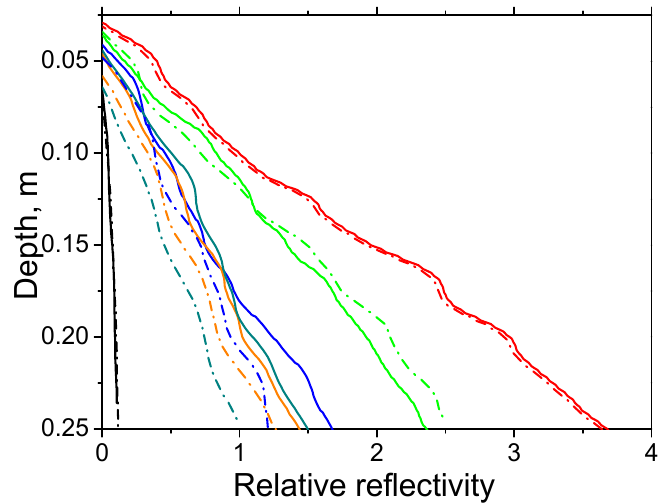
Figure 12. Relative reflectivity of sand f ( h ) for experiment 1 (sand layer thickness 0.3 m, solid lines) and experiment 4 (sand layer thickness 0.6 m, dash-dotted lines) for different drainage times indicated with lines colors: black—naturally dry sand; red—immediately after moistening; green, blue, brown, and dark blue—after 0.5, 3.5, 24, and 48 h of water drainage.